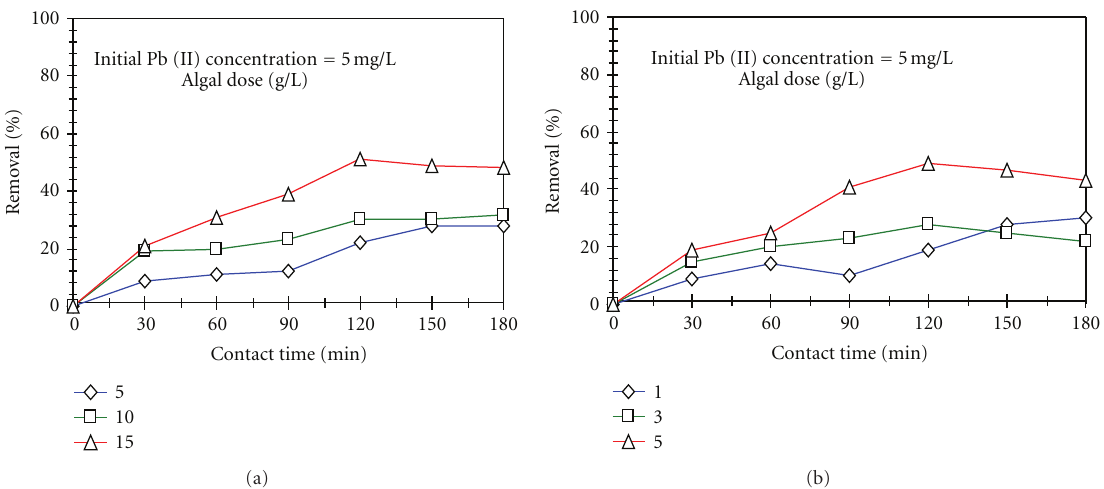
Figure 2: E ff ect of contact time on the sorption of Pb(II) by C. rivularis at natural